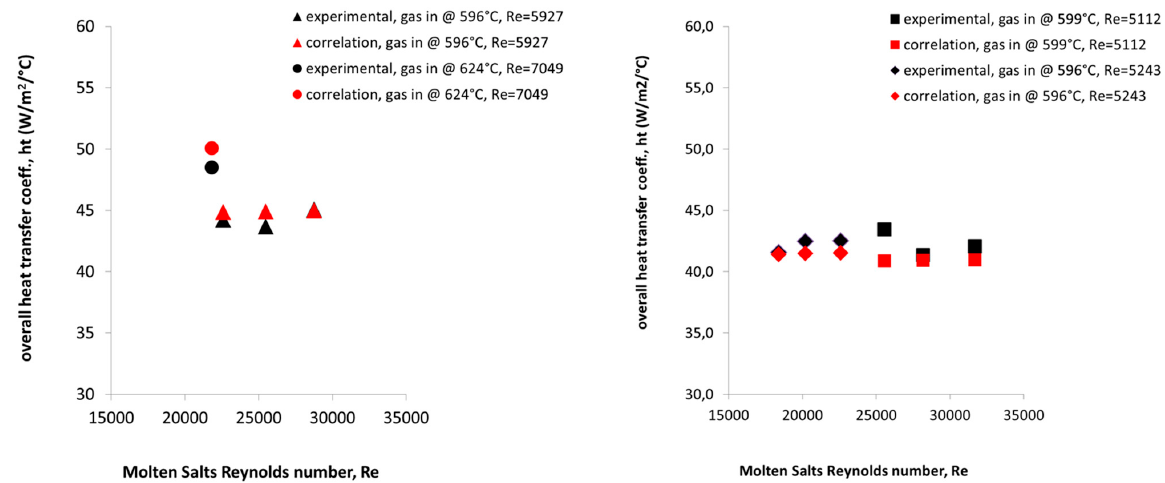
Figure 9. Comparison between experimental (black points) and theoretical (red points) values obtained for the overall heat transfer coefficient in the MSH prototype using solar salt HTF under different molten salt Reynolds and inlet “hot” gas temperatures at 596–599 °C and 624 °C.